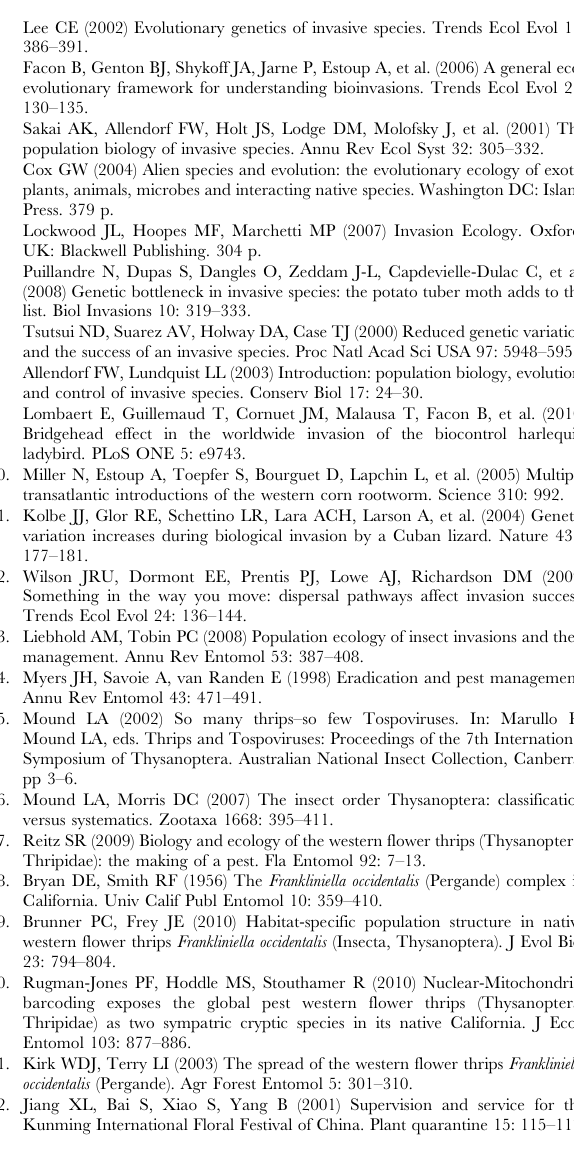
Table S1 Genetic diversity at ten microsatellite loci in 14 Frankliniella occidentalis populations in China. Table S2 Basic indices calculated using COI gene and ten microsatellites based only on WFTG individuals and haplotype distribution in Chinese populations. Table S3 Pairwise F ST matrix obtained using 10 microsatellite loci. All WFTL individuals were omitted from the respective population and were treated as a single population. Table S4 Results of assignment test and detection of first generation migrants (F0) based on WFTG individuals, with source populations list by column and recipient populations by row. Populations with sample size of # 10 individuals were not included.